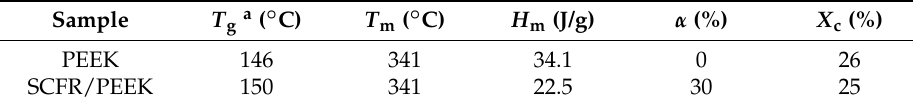
Table 2. The thermal analysis results of PEEK and SCFR/PEEK